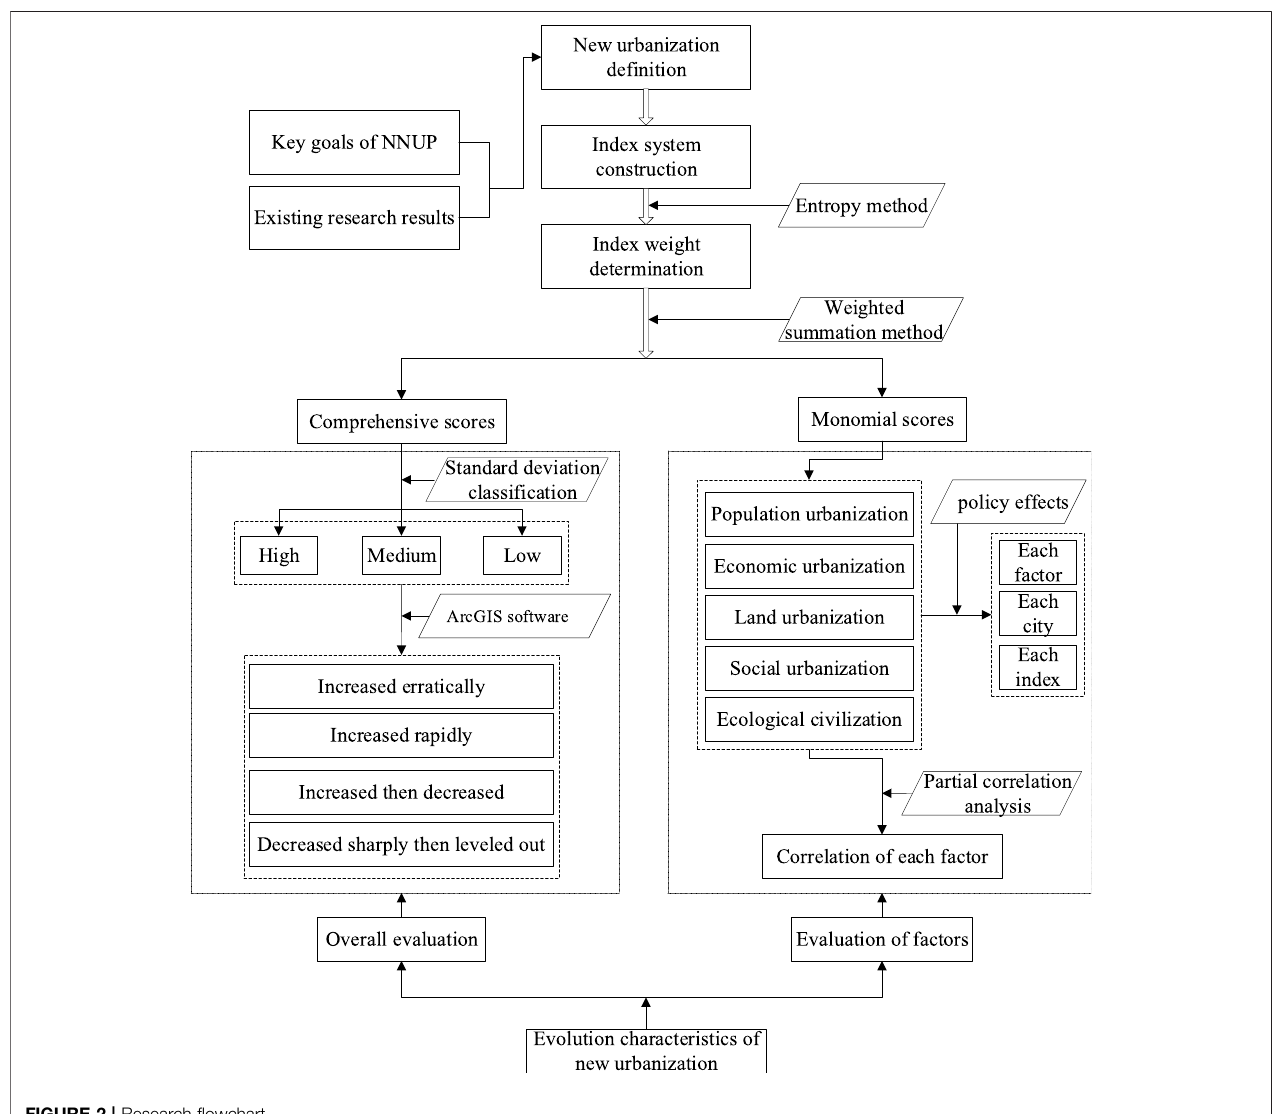
FIGURE 2 | Research fl